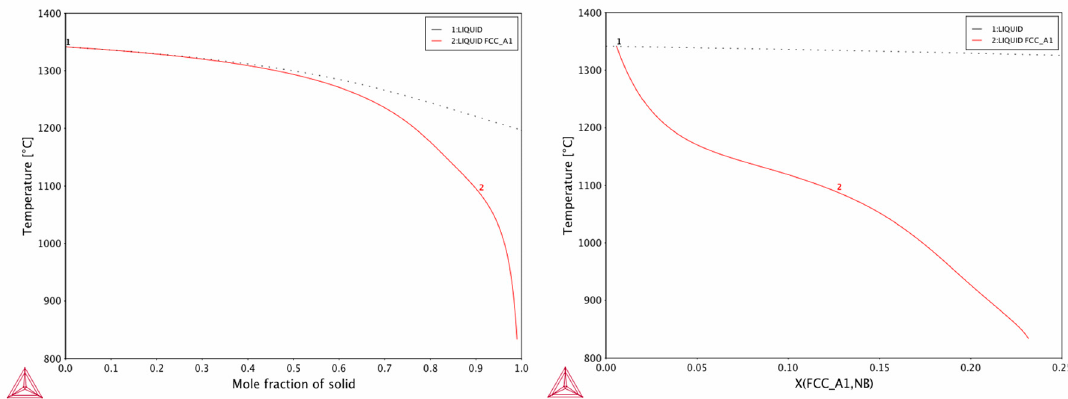
Figure 19. Scheil solidification plot for a Ni–Fe–Cr–Mo–Nb alloy with a nominal composition of IN 718.